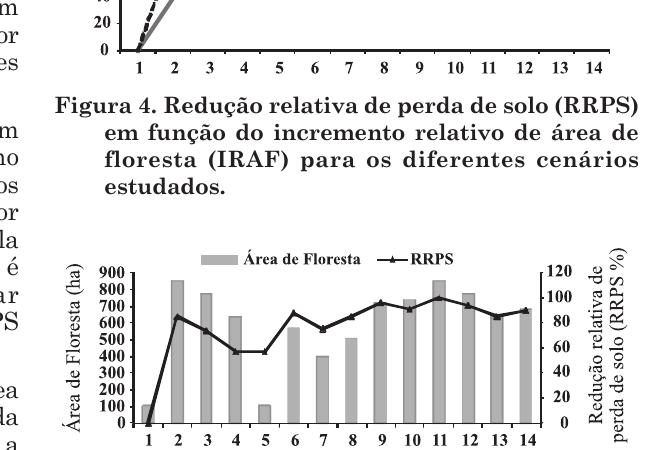
Figura 5. Redução relativa de perda de solo (RRPS) em função da área total de floresta para os diferentes cenários